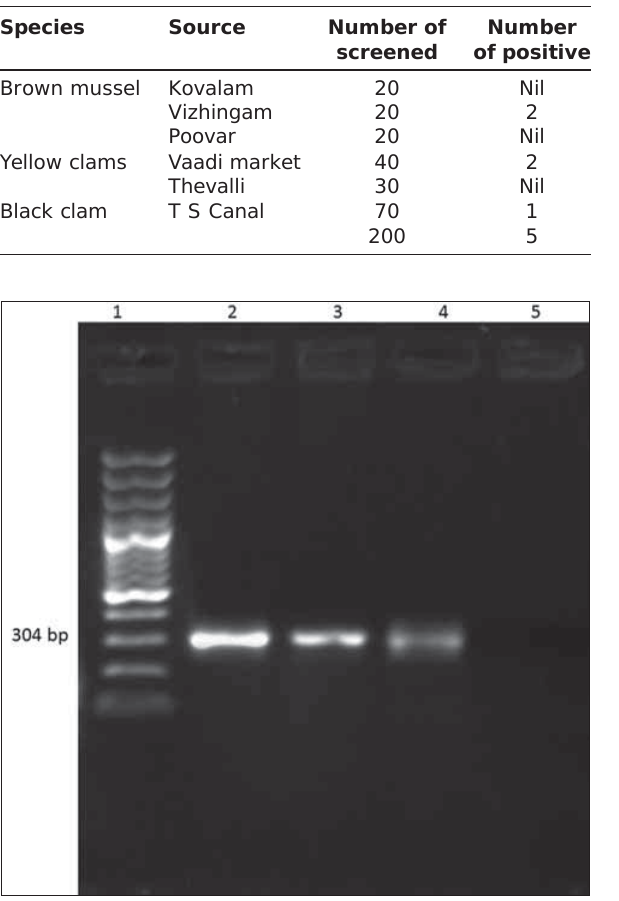
Table-3: Prevalence of Rotavirus in shellfish by RT-PCR.